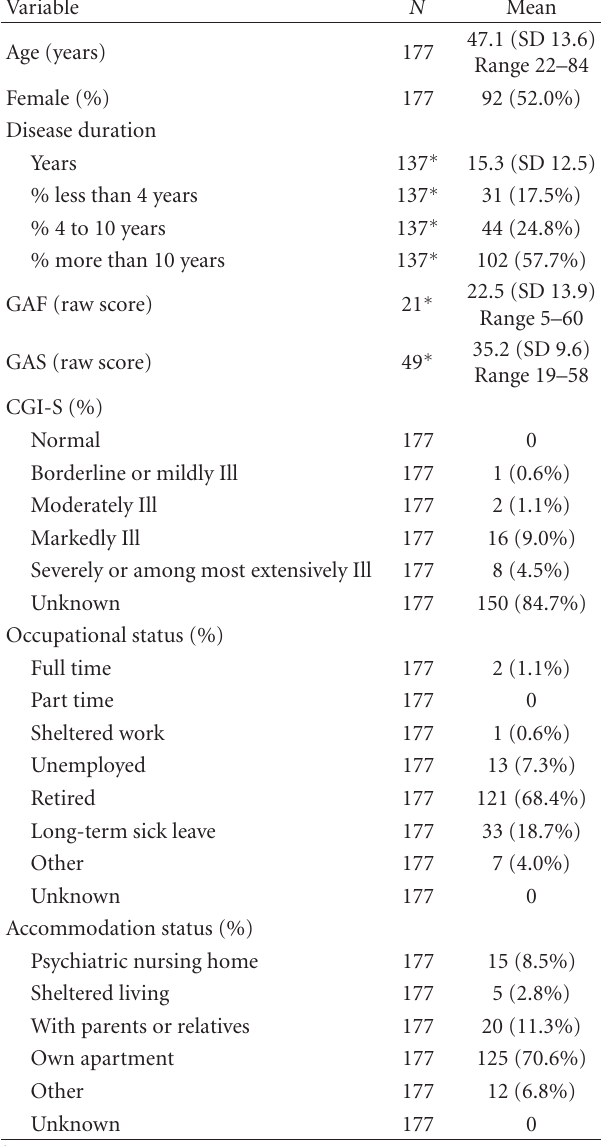
Figure 1: Illustration of the conventional allocation rule for hospitalisation episodes ongoing at the time of initiation. The start of the post-initiation period is adjusted so the entirety of hospitalisations episode overlapping the initiation date are included in the pre-switch period. Table 1: Patient characteristics at time of initiation of